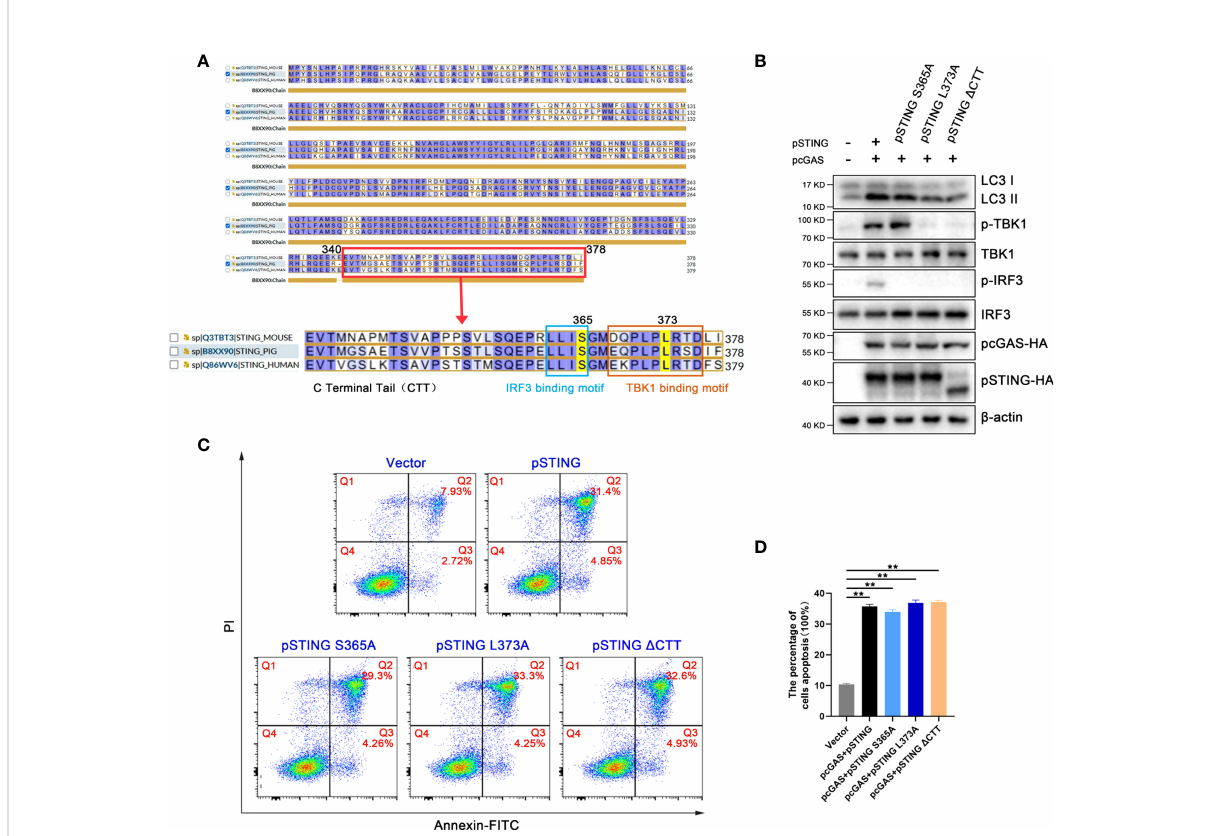
FIGURE 4 The apoptosis and autophagy induced by STING signaling are both IFN independent. (A) The alignment of human, mouse and porcine STING with CTT domain enlarged, IRF and TBK1 recruitment motifs box marked. The pSTING S365 in IRF recruitment motif and L373 in TBK1 recruitment motif are also indicated. (B, D) 293T cells were co-transfected with pcDNA-pcGAS-2HA (0.5 m g) plus pcDNA-pSTING-2HA, pSTING S365A, pSTING L373A or pSTING D CTT (each 0.5 m g) for 24 h, followed by Western blotting (B) and fl ow cytometry (C, D) . ** p <